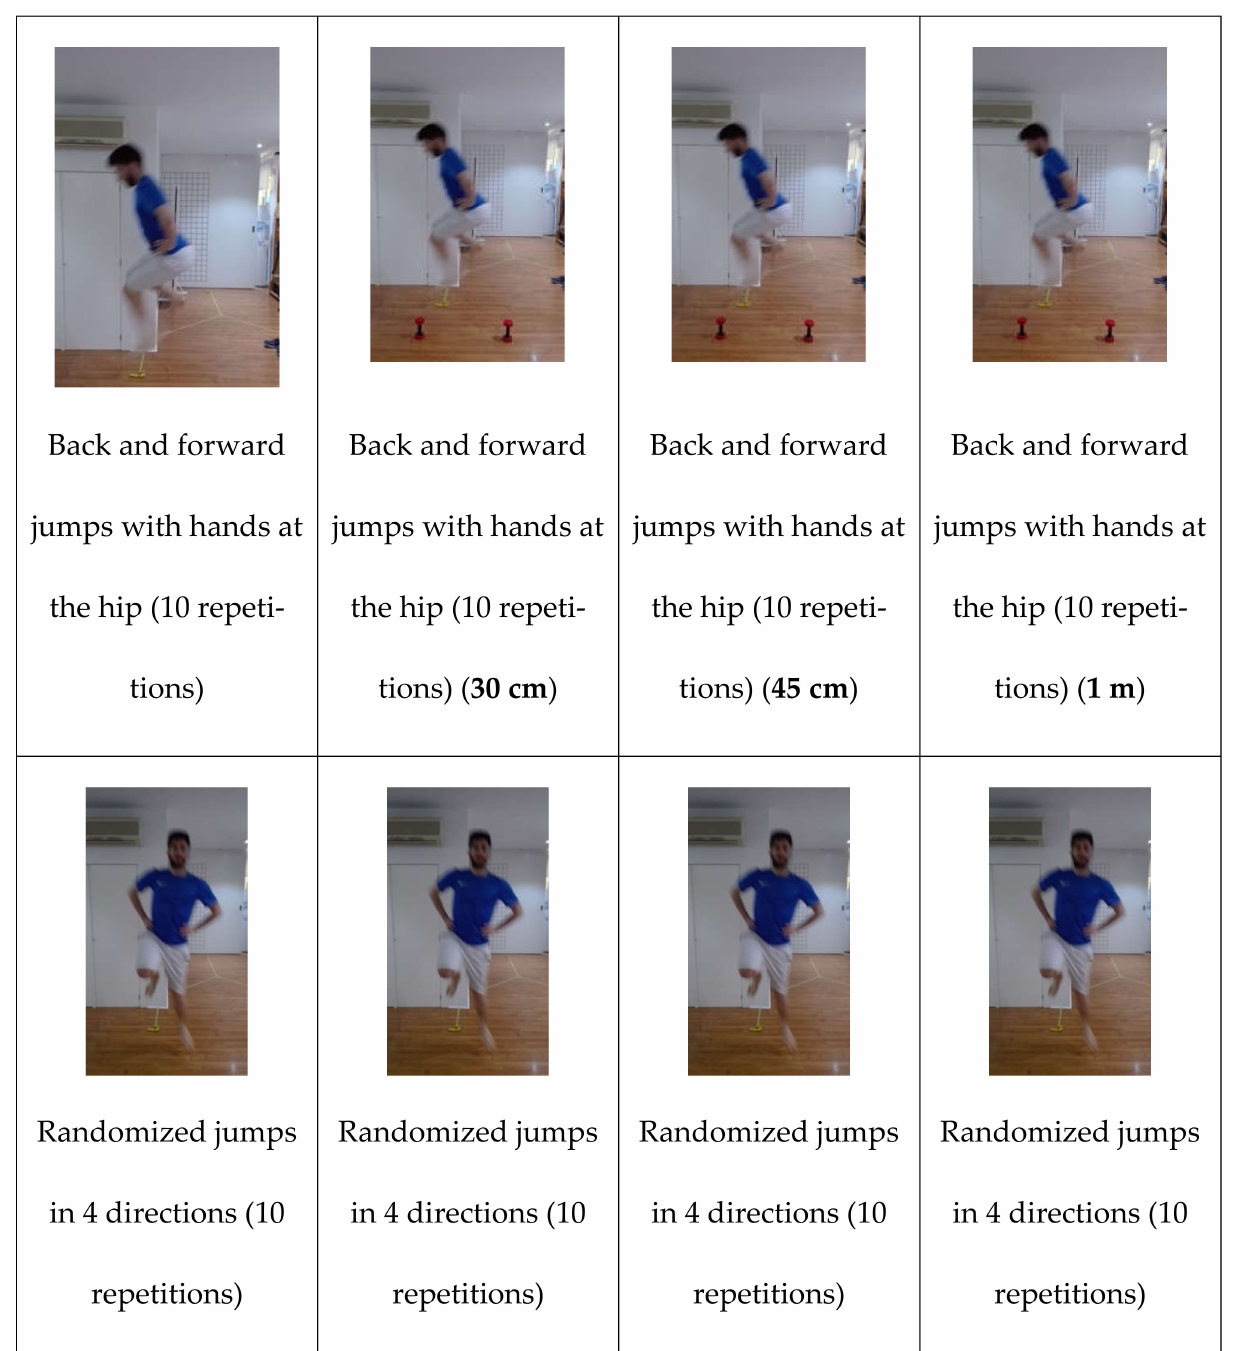
Figure 1. Neuromuscular